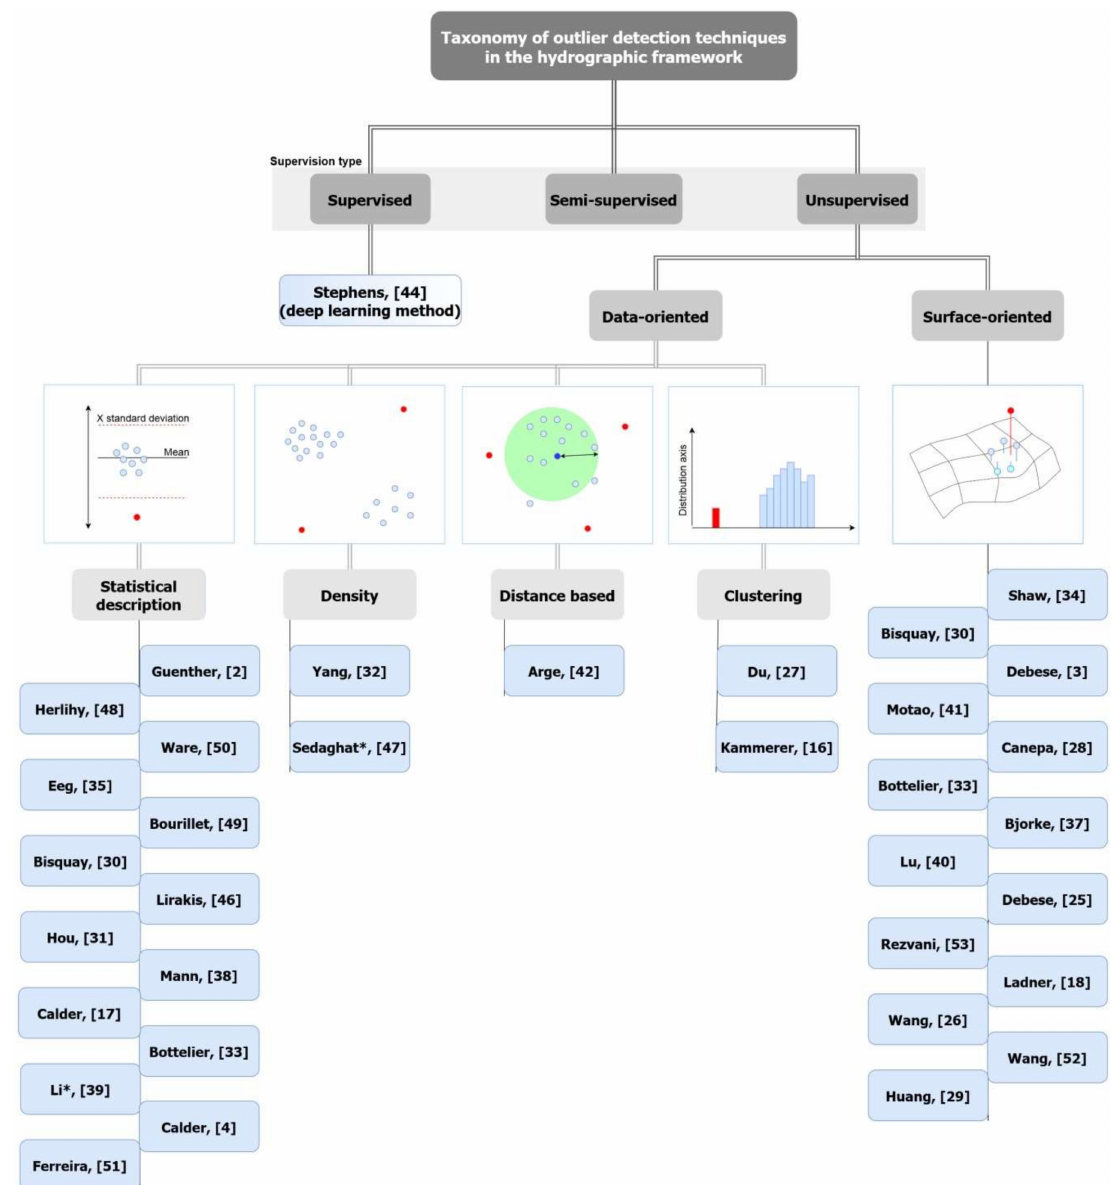
Figure 6. Taxonomy of outlier detection techniques in the hydrographic framework. Approaches describing several algorithms within the same class (data-oriented or surface-oriented) only appear once. * Li and Sedaghat approaches use singlebeam opportunity